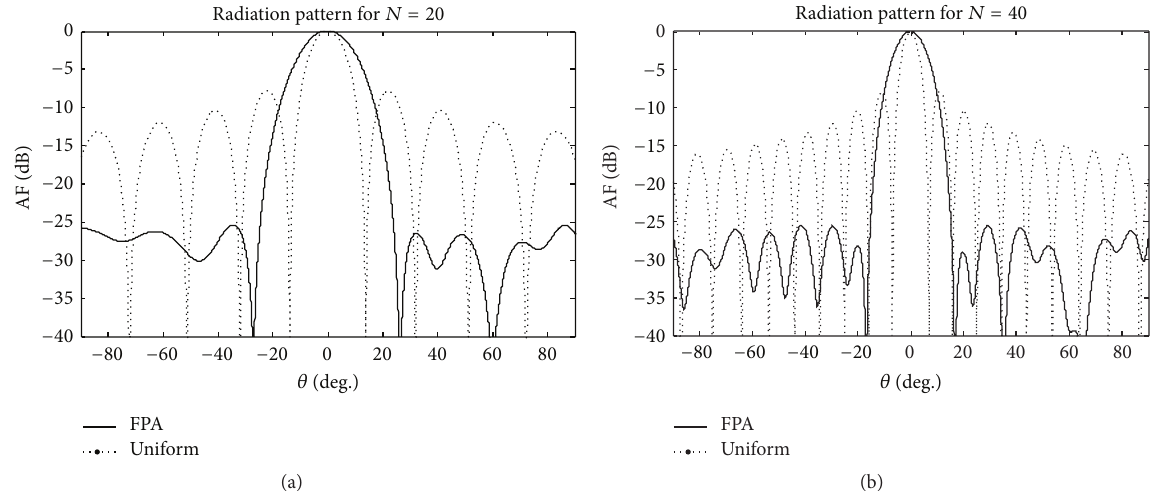
Figure 5: Comparison of the radiation patterns of CAA using weights obtained by FPA and uniform distribution for (a) 𝑁 = 20 and (b) 𝑁 = 40 .